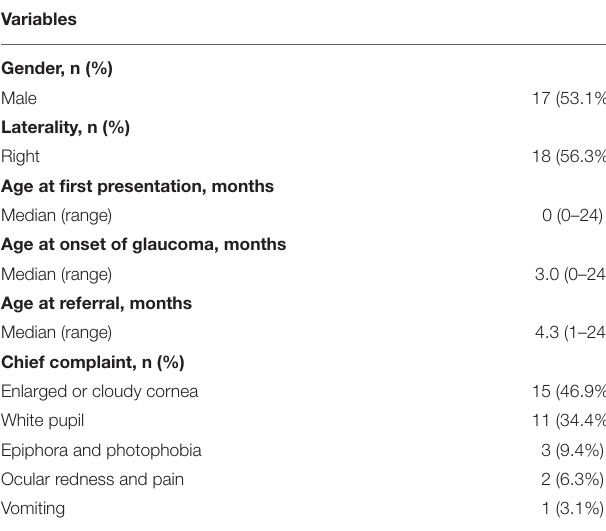
TABLE 2 | Comparison between affected and fellow eyes in subjects with congenital fibrous pupillary membrane-induced secondary glaucoma at the time of